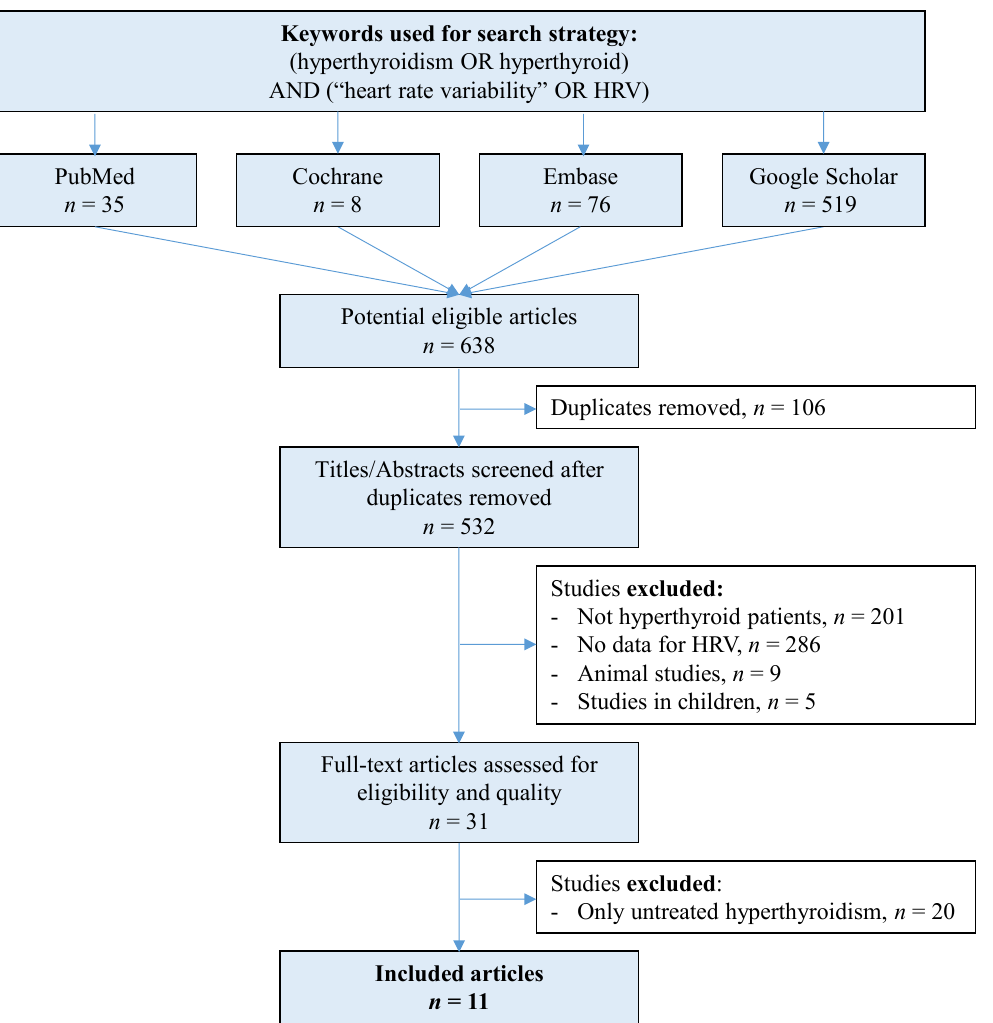
Figure 1. Flow chart. We followed the Preferred Reporting Items for Systematic Reviews and Meta- Analyses (PRISMA) guidelines for the search strategy. HRV: heart rate variability. The study protocol was registered and received INPALSY registration number: